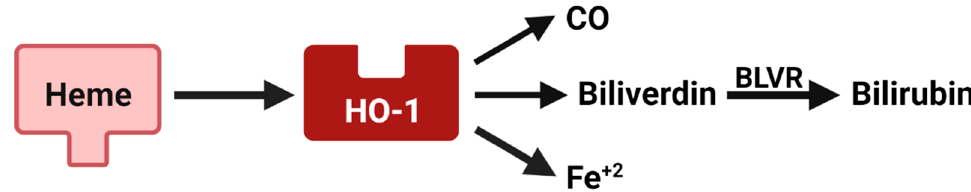
Figure 4. Heme metabolism pathway. Heme oxygenase-1 (HO-1) degrades heme into three immune modulatory byproducts, carbon monoxide (CO), ferrous iron (Fe +2 ) and biliverdin. Biliverdin is quickly converted to bilirubin via biliverdin reductase (BLVR). This figure was made with biorender.com.